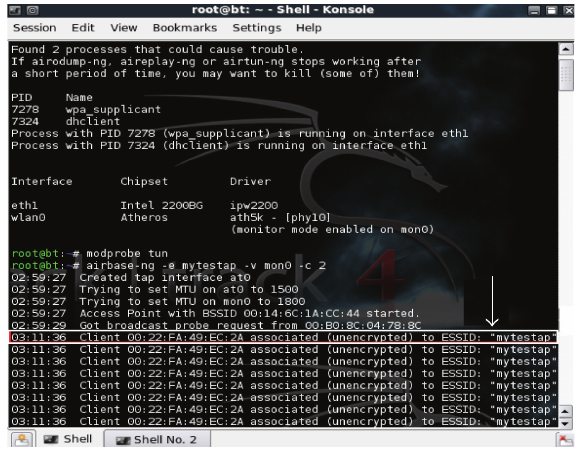
Figure 4: The first victim connected to the rogue access point.